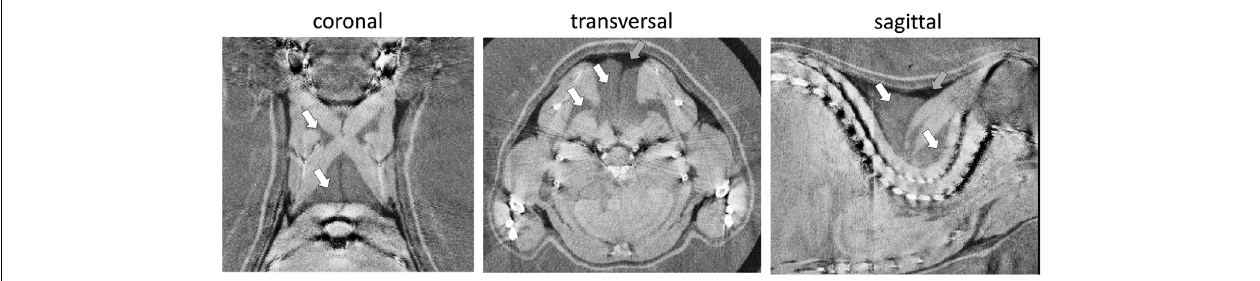
FIGURE 1 | Representative phase-contrast computed tomography images of the murine upper thoracic region in the coronal, transversal, and sagittal plane. Brown adipose tissue (white arrows) can clearly be distinguished from overlaying white adipose tissue (darker, less electron dense; gray arrows) and bounding muscular structures (lighter, more electron dense). The electron density is displayed in a linear range from 310 to 350 e/nm 3 .